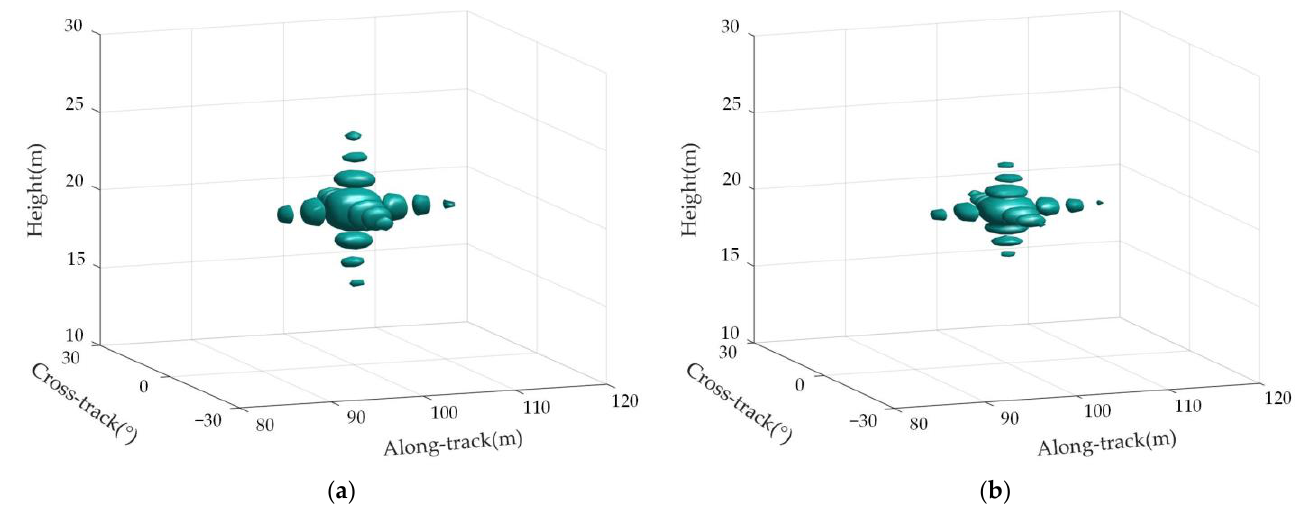
Figure 9. A 3D image of single-point targets. ( a ) Point P5 3D image; ( b ) point P9 3D image.